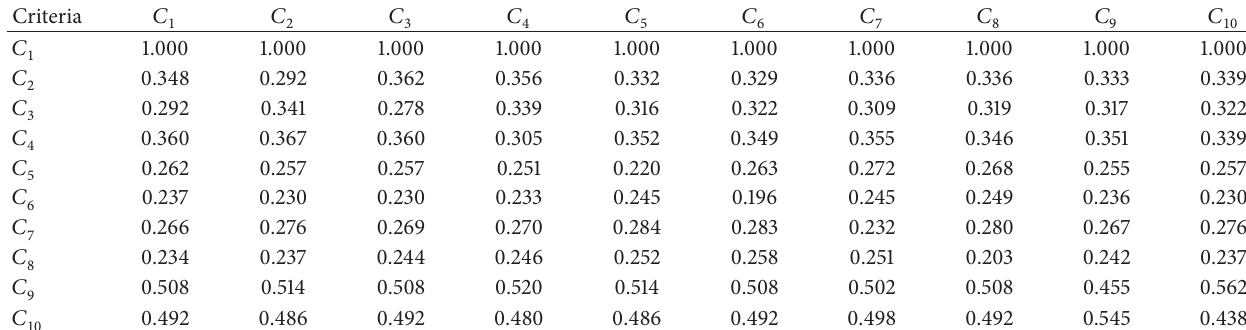
Table 5: The unweighted supermatrix.